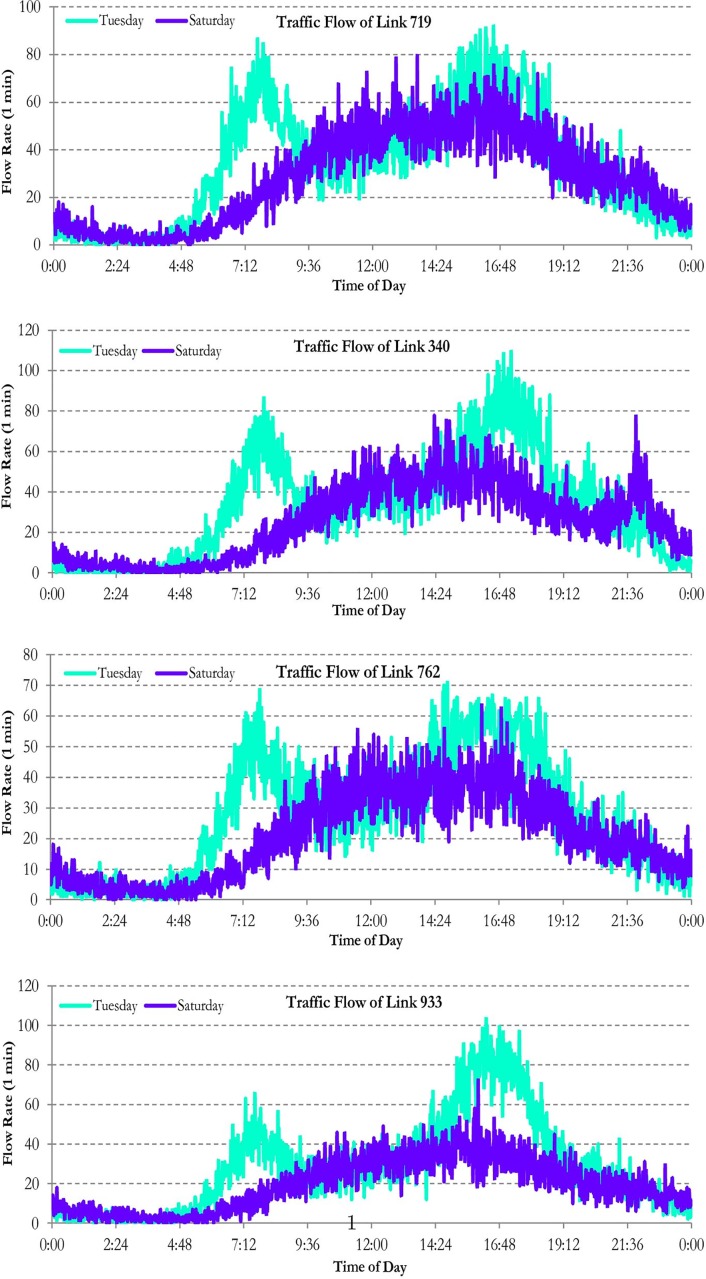
Traffic flow of selected sections for February 24th and 28th, 2015.